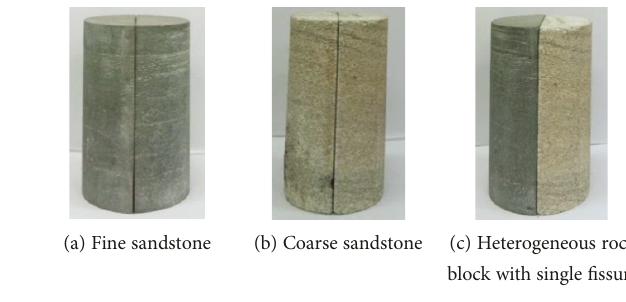
Figure 1: Single fi ssure rock block.